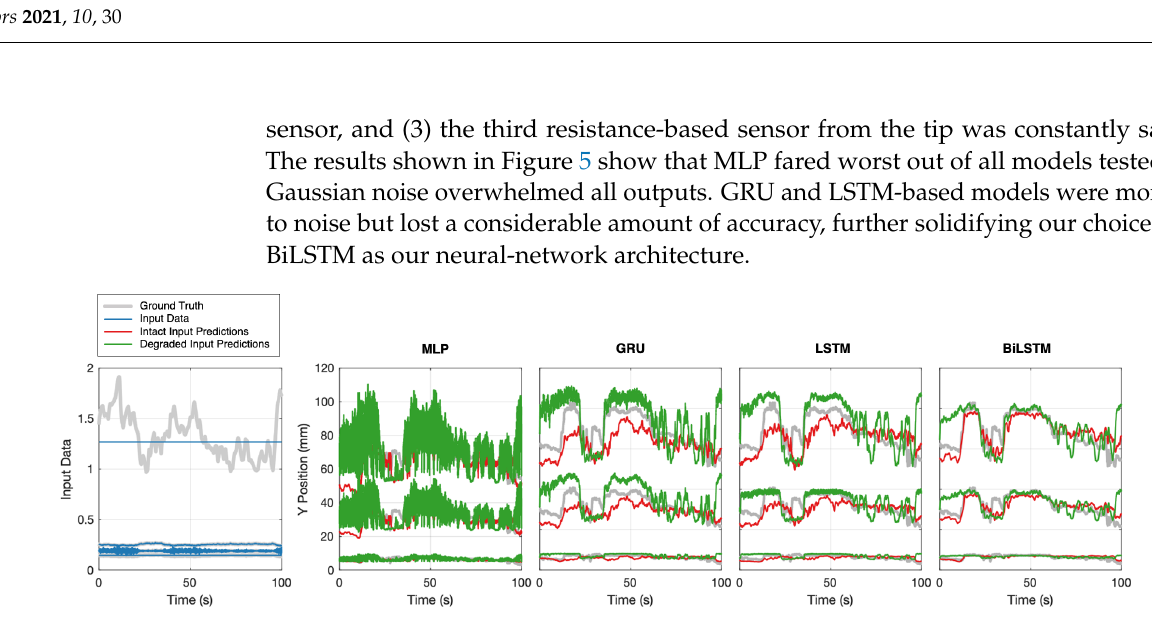
Figure 5. Results from comparing across models with the following conditions: (1) pressure data were constantly saturated, (2) Gaussian noise was multiplied to the data from sensor 2, and (3) sensor 3 was constantly